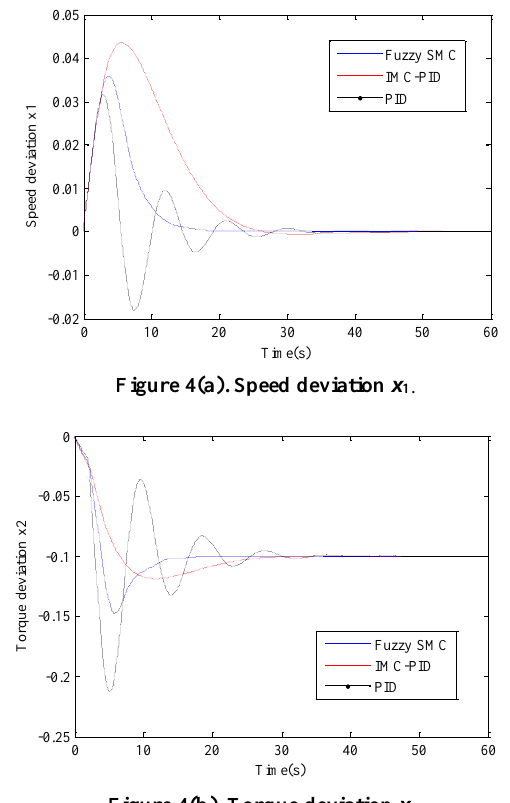
Figure 4(d). Additional state x 4.